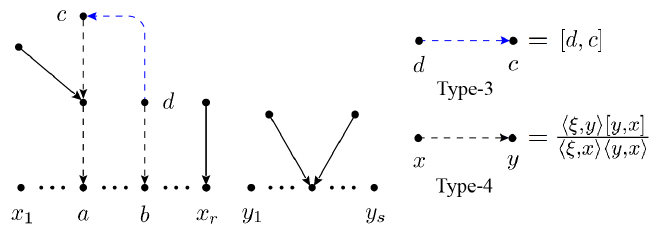
Figure 2 . A typical new graph for double-trace ( g − , g − ) -amplitude consists of two mutually disjoint parts, while the left part corresponding to the trace 111 contains a bridge formed by a type-3 edge and several type-4